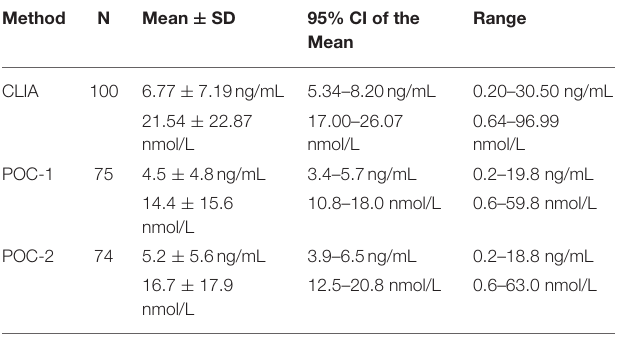
TABLE 1 | Descriptive statistics for progesterone concentrations obtained from 100 canine serum samples analyzed using a reference chemiluminescent immunoassay (CLIA) and two point-of-care analyzers (POC-1 and